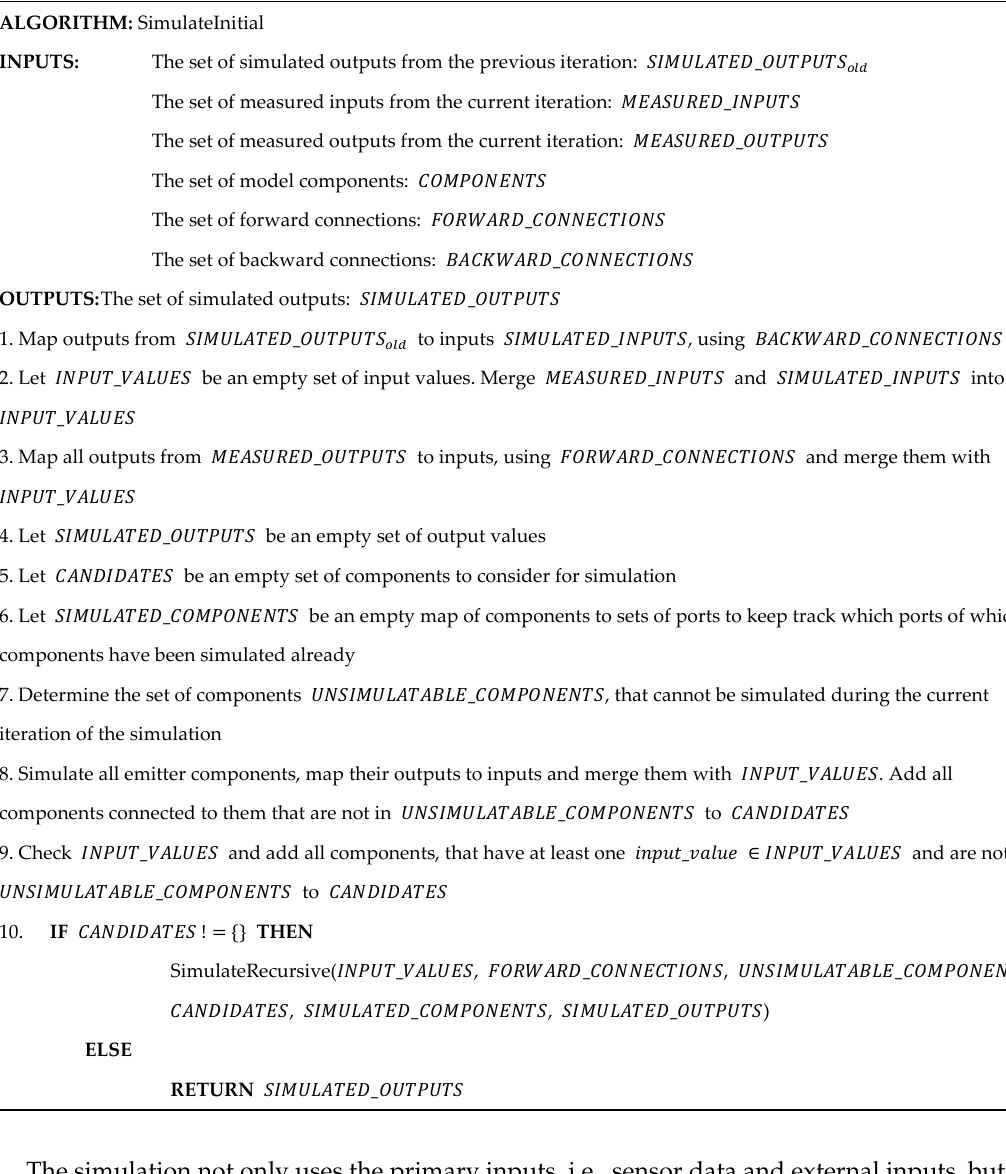
Algorithm 1. Pseudo code of the SimulateInitial-function of the simulator, used to perform initial computations e.g., the simulation of emitters and to initialize the necessary data structures for further simulation of the